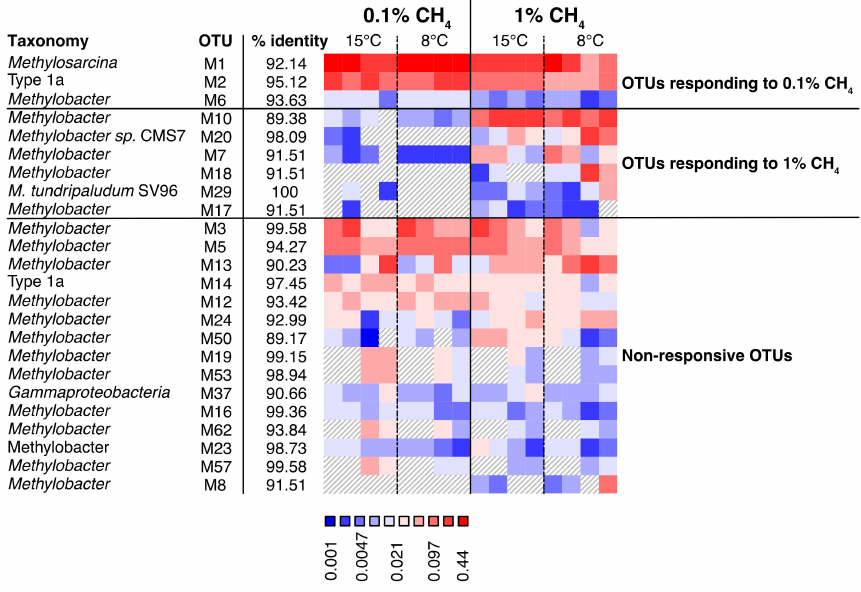
Figure 8. Relative abundances of pmoA transcripts representing MOB OTUs (A189F/mb661R primer pair) from exclosed peat soil microcosms after incubation at 0.1% and 1% CH 4 concentrations. OTUs with higher relative abundance at 0.1% CH 4 are shown in the first block (left) and those with higher relative abundance at 1% CH 4 in the second block (right). The non-responsive OTUs with the highest relative abundance are shown in the third block. The number of OTUs included in the figure make up 90% of the total MOB community transcription. OTUs are identified by the letter M (indicating that these are part of the mb661R dataset) and a number. The percentage of identity between the OTU and the best hit in the database is given next to the OTU identification. The highest possible taxonomic rank identified was chosen for each OTU. Relative abundances reach from low abundances (blue) to high